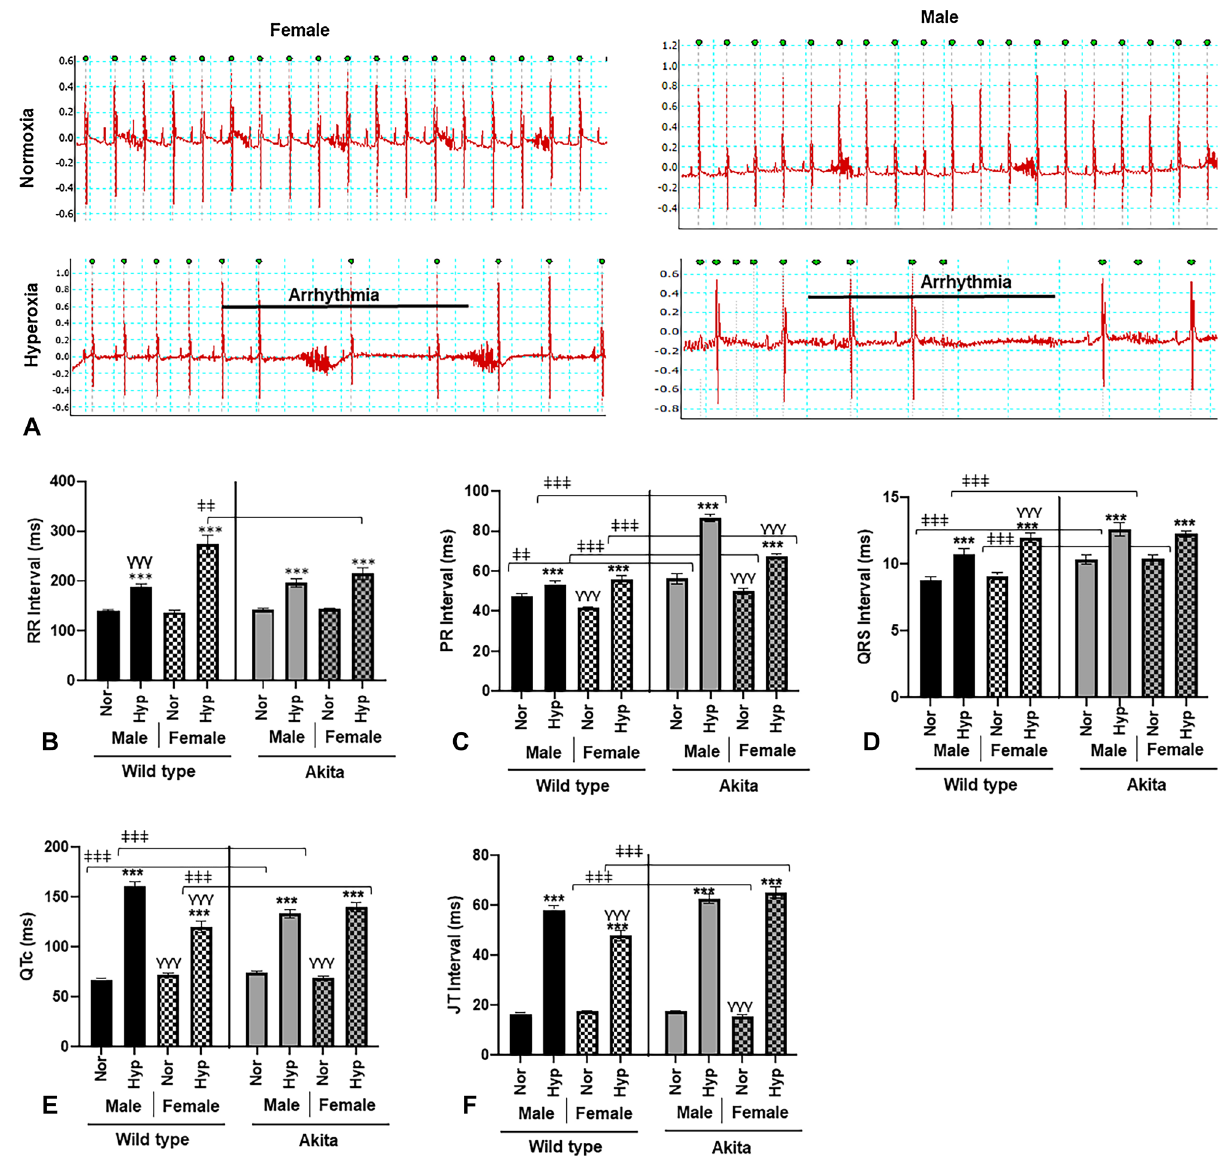
Figure 3. Hyperoxia induces bradyarrhythmias in Akita (and WT) mice ( A ) Original ECG traces in lead II mode in normoxia/hyperoxia treated Akita male and female mice, ( B ) RR interval, ( C ) PR interval, ( D ) QRS interval, ( E ) QTc interval, ( F ) JT interval. Error bars represent ± SEM. *p < 0.05, **p < 0.005 ***p < 0.0005. *compares effects of hyperoxia and normoxia of same gender and strain; Y compares male and female mice of the same strain and treatment; ‡compares WT and Akita of same gender and